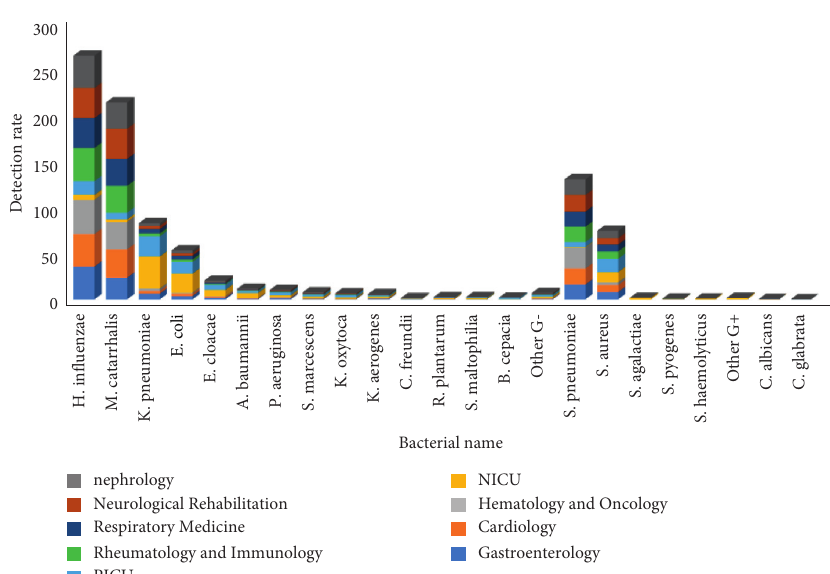
Figure 11: Distribution and constituent ratio of pathogens in lower respiratory tract in different departments isolated from 2018 to 2020